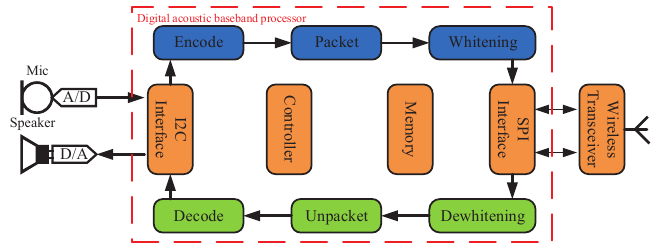
Figure 5. Block diagram of the Digital Acoustic Baseband